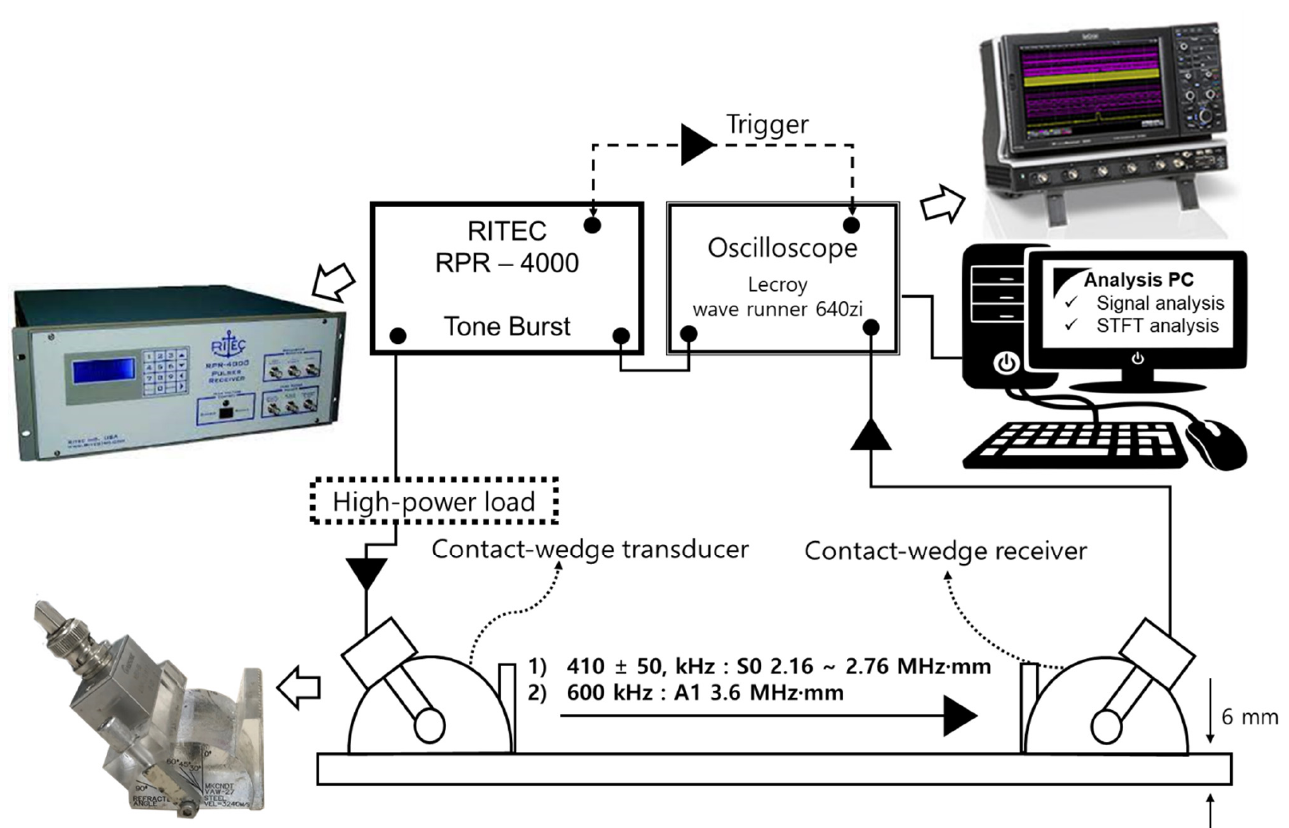
Figure 6. Experimental setup for generating PZT-based Lamb waves.